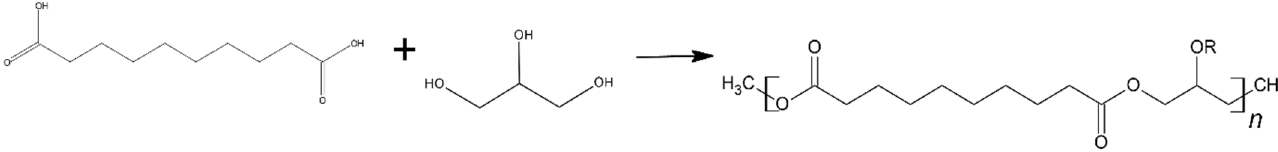
Figure 14. Schematic of PGS synthesis.